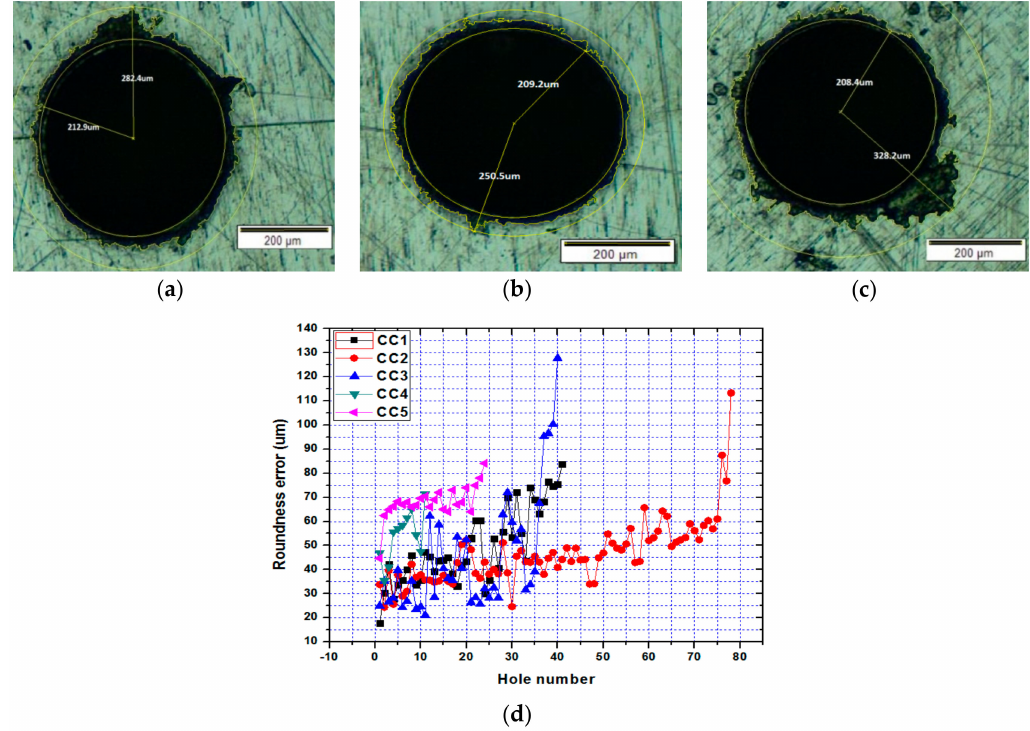
Figure 5. Images of drilled holes ( a ) no.1, ( b ) no. 40, and ( c ) no. 79 for the cutting condition 2 (CC2); ( d ) variations of roundness error with respect to the hole numbers with di ff erent cutting